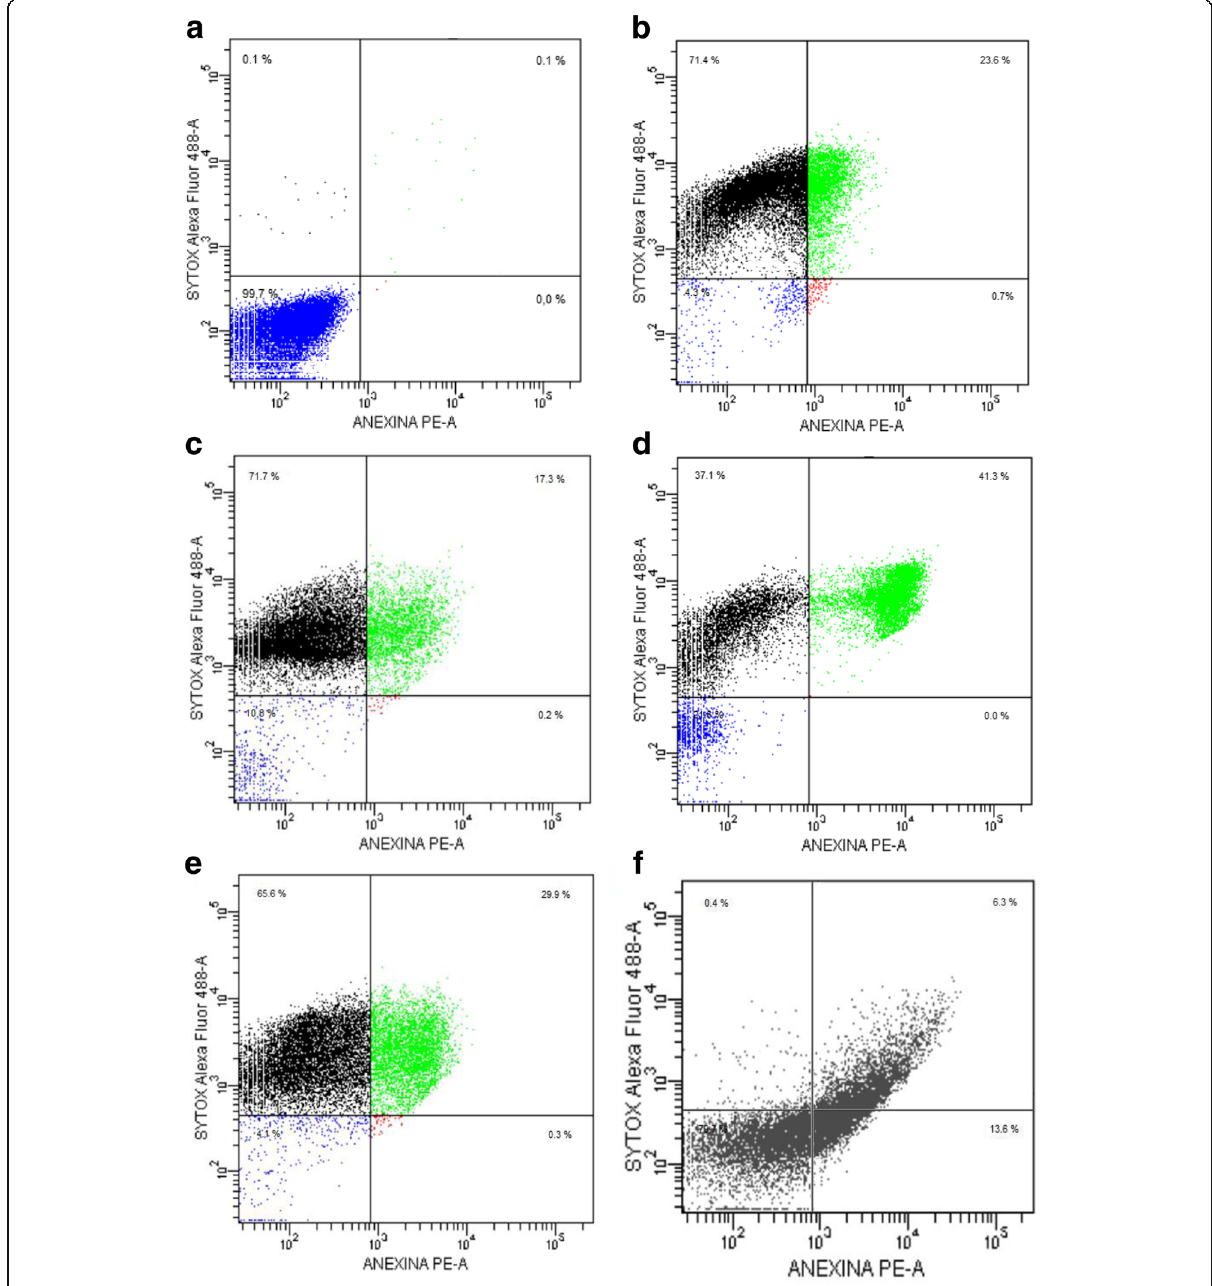
Fig. 5 Flow cytometry analysis of phosphatidylserine externalization of T. cruzi epimastigotes treated with terpenes or Benznidazole. a Negative control (untreated culture). b caryophyllene oxide; c limonene; d citral; e limonene:BNZ; and f apoptosis positive control (15 day-old parasite culture). The flow cytometry histograms are representative of two independent